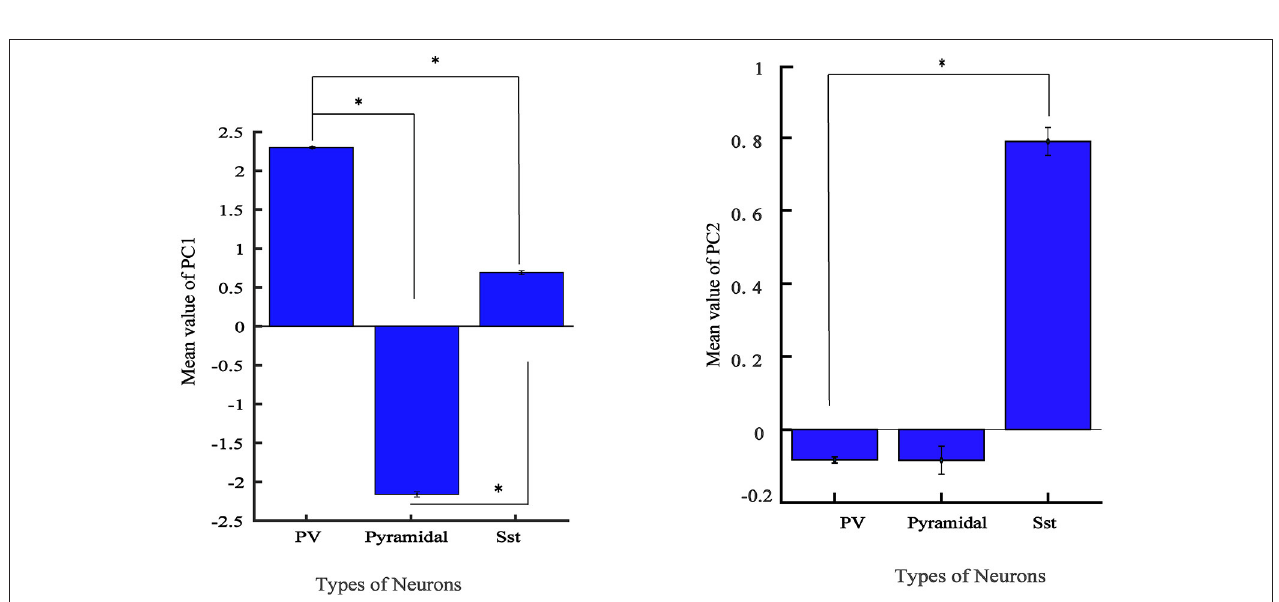
FIGURE 5 | Values of feature in the first 2 PCs in three electrophysiological classes of neurons in mice V1. Bar graph shows the mean values of PC for different groups and error bar shows the SEM value. (*adjusted p value < 0.05,